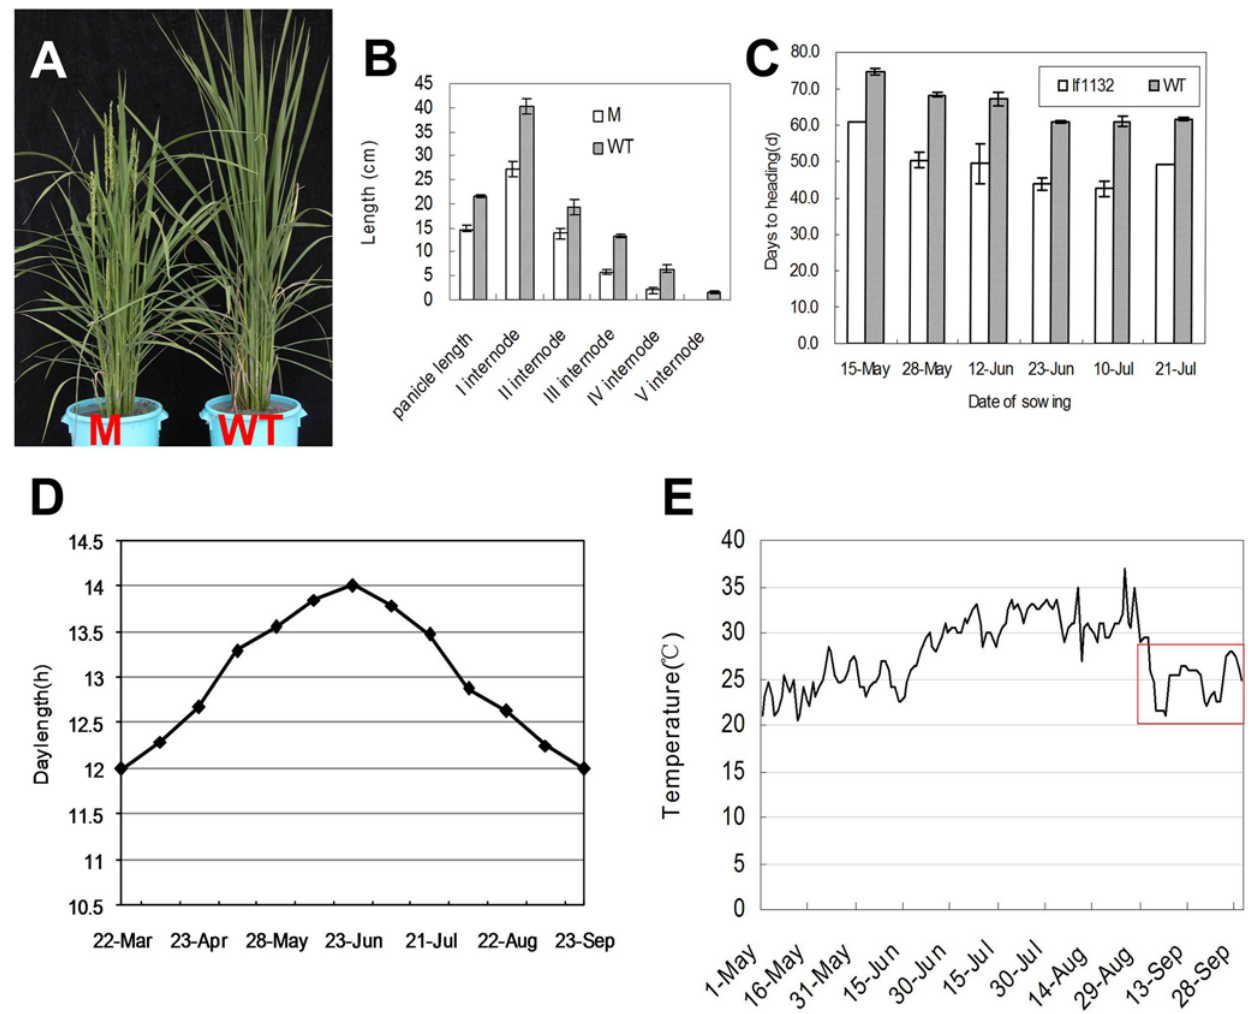
Figure 1. The phenotype of the mutant. A: the phenotype of the mutant and wild type, M is mutant lf1132 ; WT is Zhonghua 11. B: the panicle length and internode length for mutants and wild type. 15 total plants were investigated from five repeats containing three individuals. C: The heading-date of the wild type and mutant on different sowing-dates. Wild type and mutant were planted in the CNRRI experimental field, Zhejiang province on six sowing-dates from 15, May to 21, July 2007. D: The change in photoperiod during different sowing-dates. E: The change in temperature (mean value of everyday temperature) during different sowing-dates. Red box indicates the temperature of the heading period at the last sowing-date, 21, July.